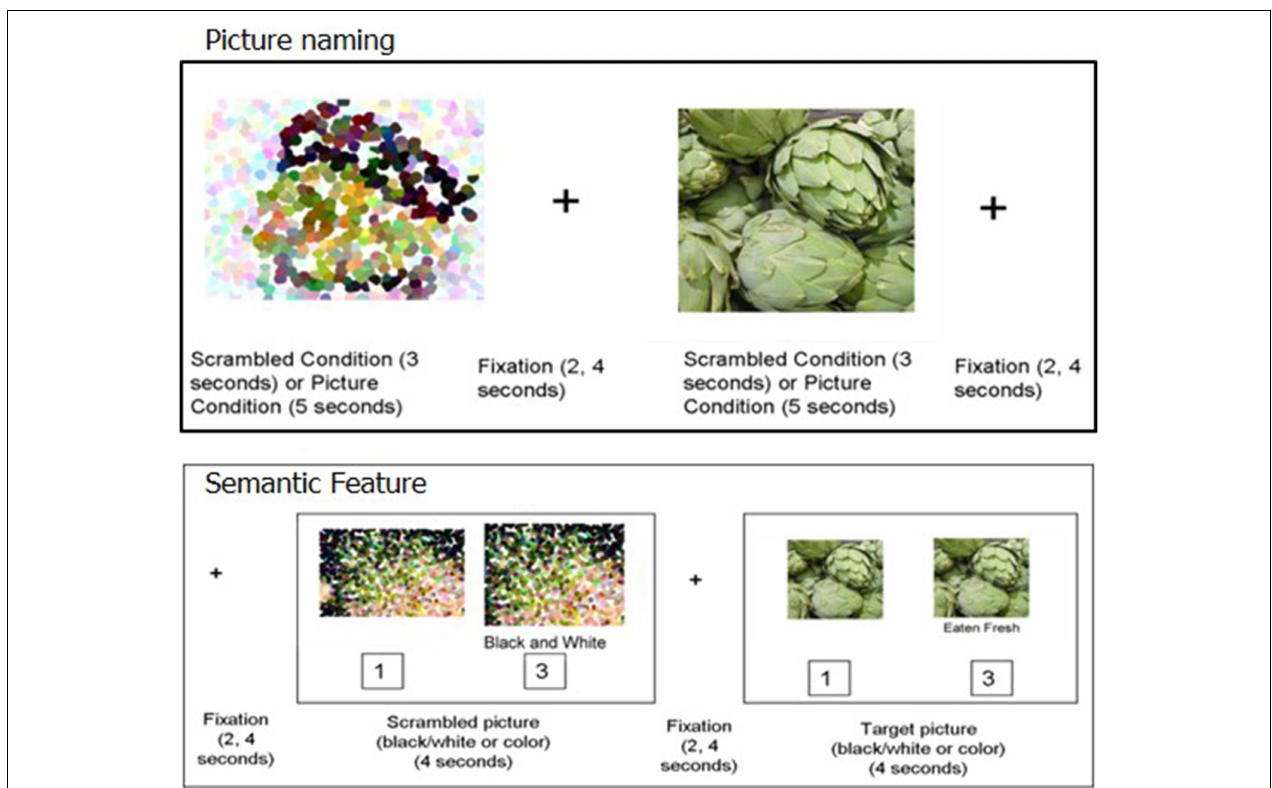
FIGURE 2 | Picture naming (top) and Semantic feature task